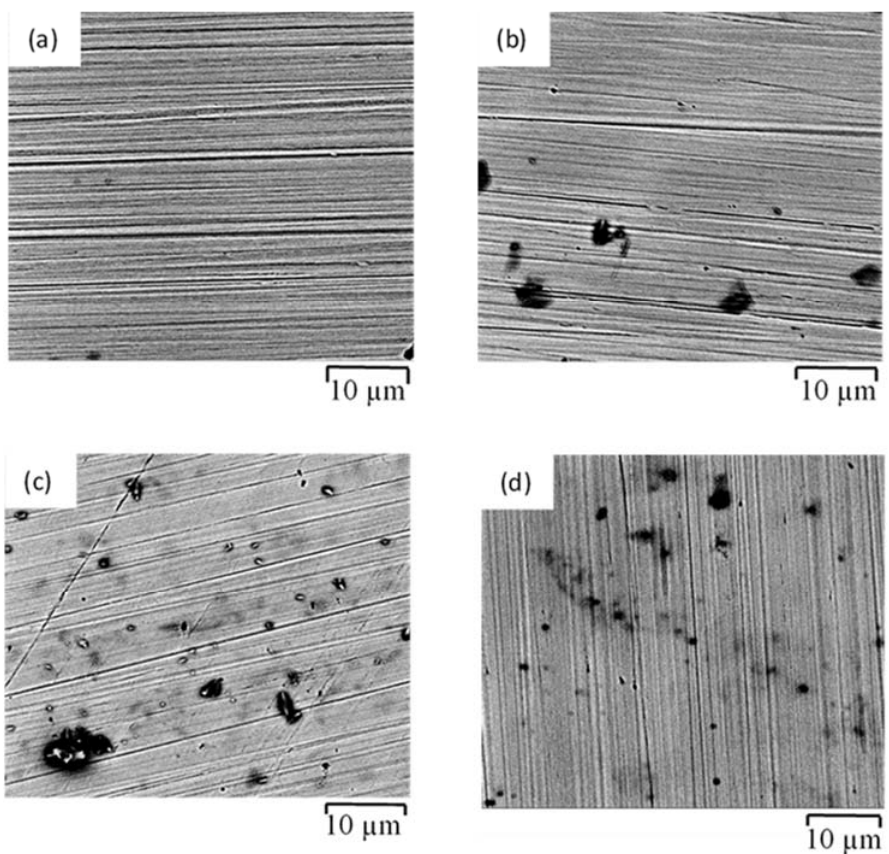
Figure 15. SEM images of morphology SS316 exposed to different simulated solutions of: ( a ) SW for 168 h, ( b ) NC for 168 h, ( c ) SWSSNC 72 h and ( d ) SWSSHPC 72 h.